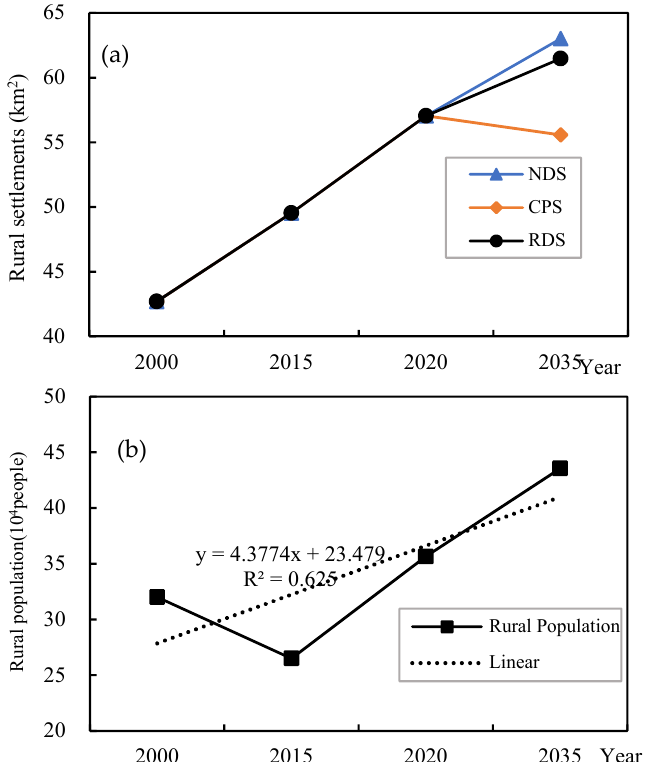
Figure 7. Time-series changes in rural settlements and rural population in Deqing from 2000 to 2035 (NDS, CPS, and RDS).